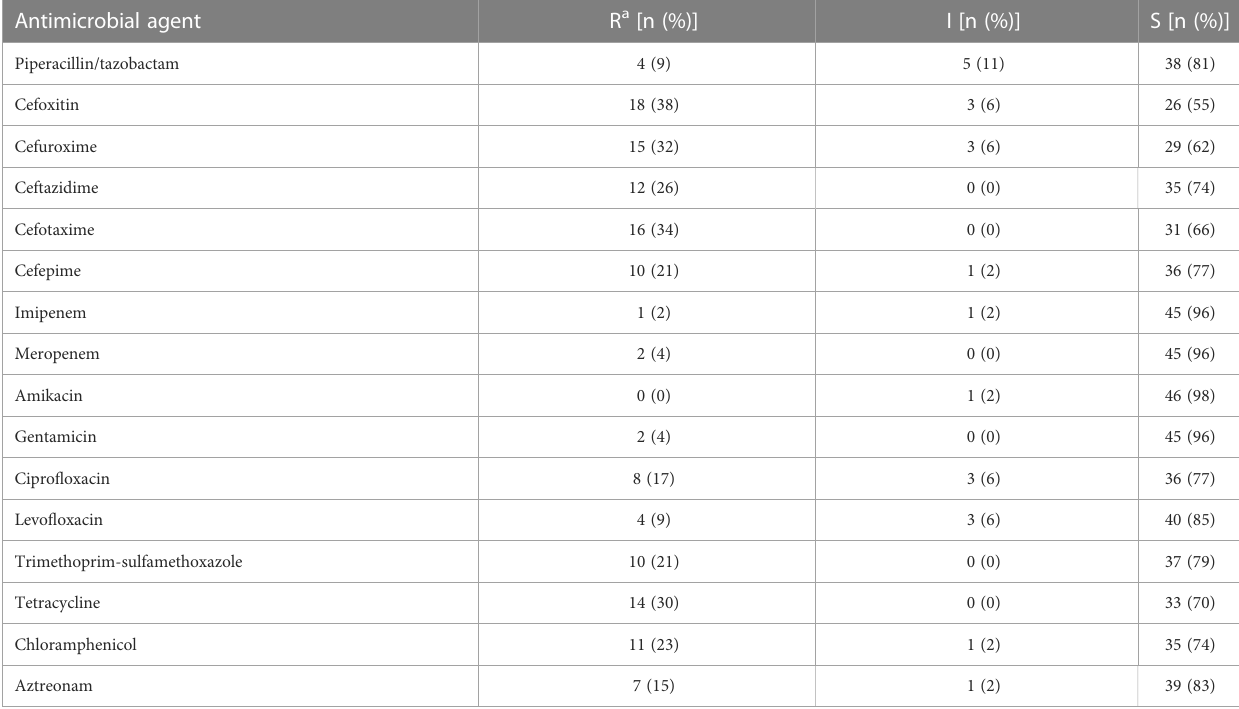
TABLE 2 Antimicrobial susceptibility patterns of 47 A. caviae strains iaolated from extra-intestinal infections. Antimicrobial